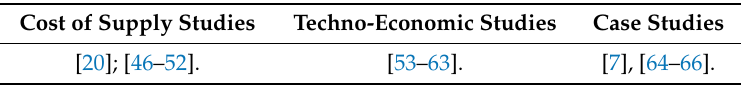
Table 3. Selected studies on viability of mini-grid based electricity